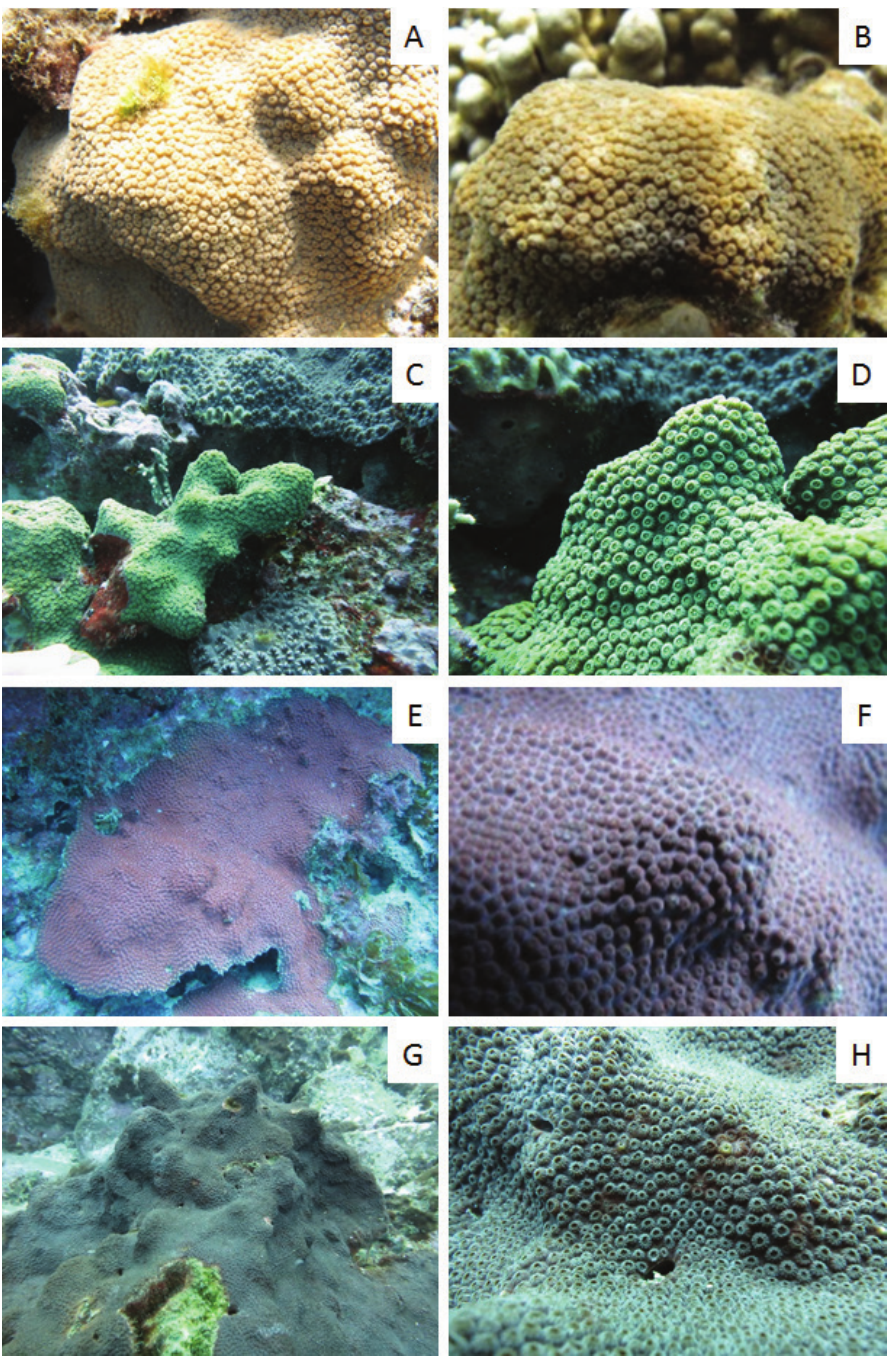
Figure 2. Cyphastrea salae in situ. A, B AM 81-1414 C, D AM 81_3953 E, F AM 81_1822 G, H AM